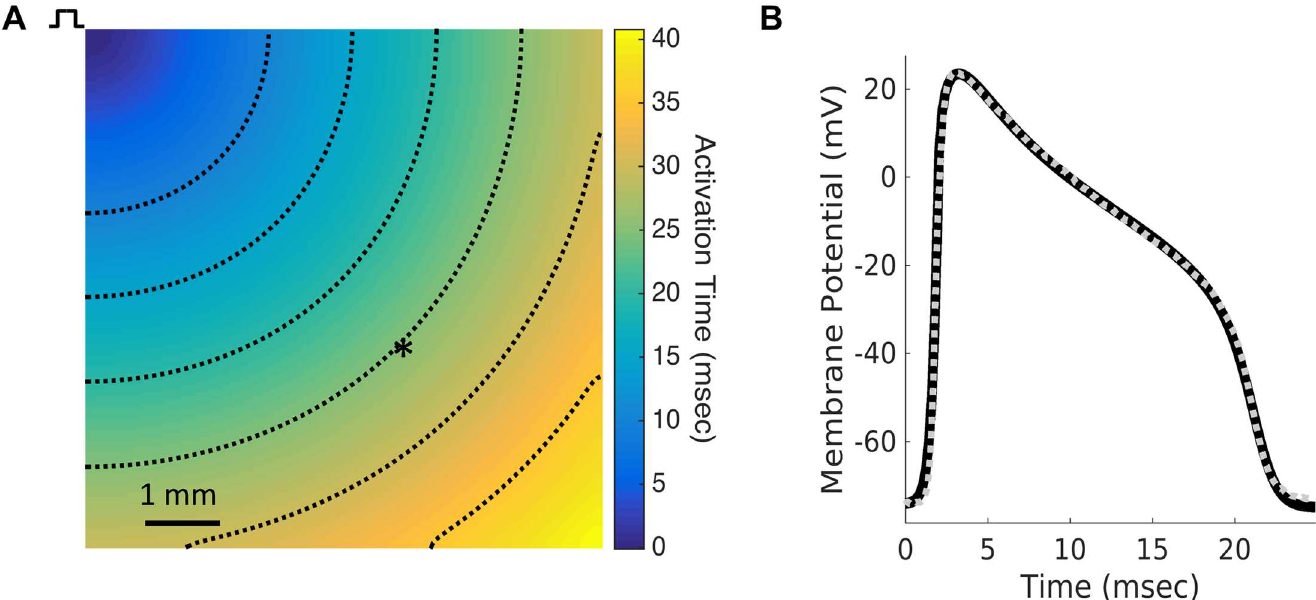
Fig 2. Model action potential replicates experimental action potential. (A) Model fitting was performed by simulatingconductionin a 2-D monolayer and recording an action potential 6 mm from the stimulus site (asterisk). Dashedlines are isochrones of activationat intervals of 5 ms. (B) The action potential generatedby the fitted Ex293 membranemodel (solid black line) replicates the morphology of the experimentally-recorded Ex293 action potential from [7] (dashedgray